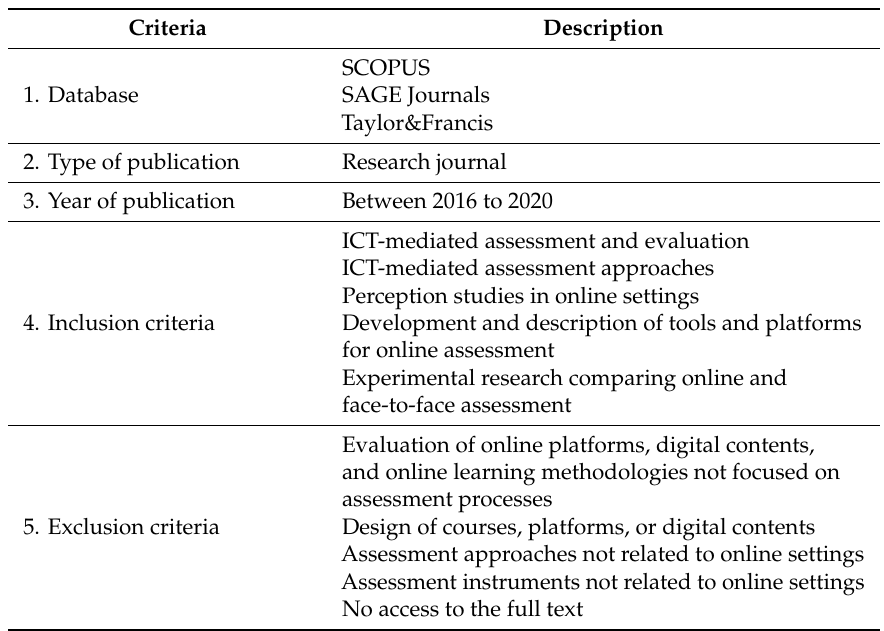
Table 1. Search criteria for the systematic